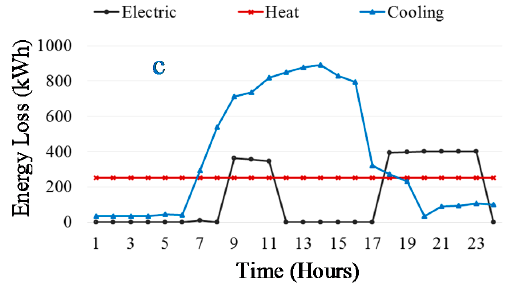
Figure 9. Energy balancing of EEN in summer season: ( a ) electrical energy; ( b ) heating energy; and ( c ) energy loss.